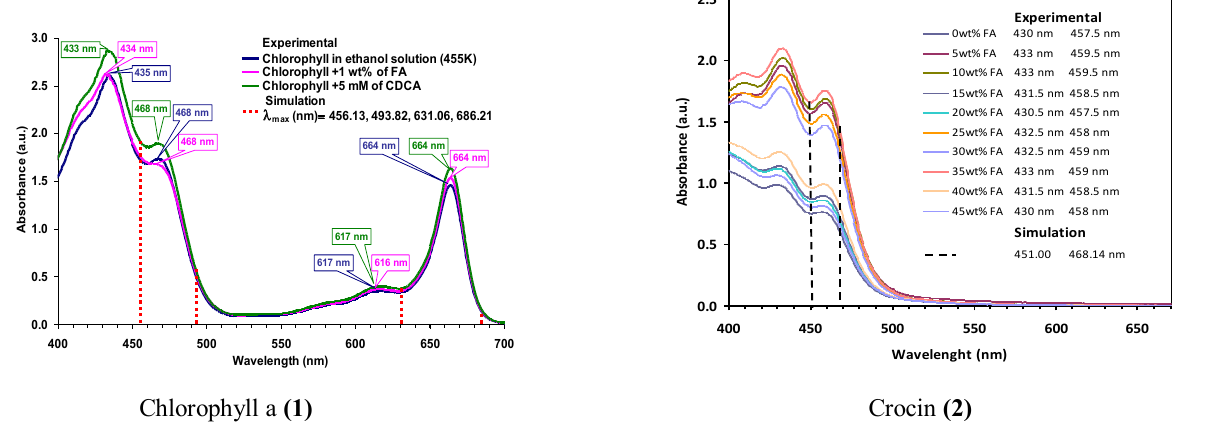
Figure 2: Experimental UV-Vis spectra and theoretical simulations of Chlorophyll a (1) and Crocin (2) .